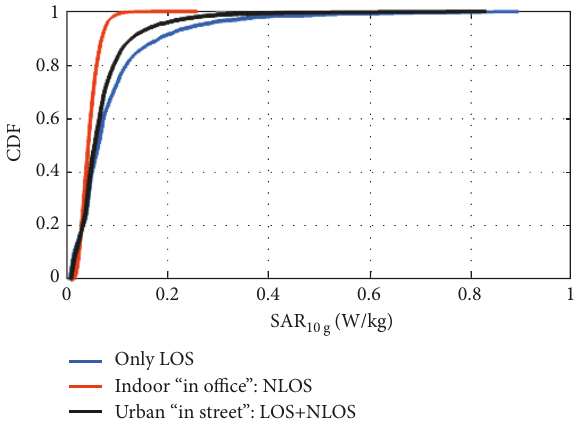
Figure 8: SAR 10 induced by the mobile phone at 900 MHz. g